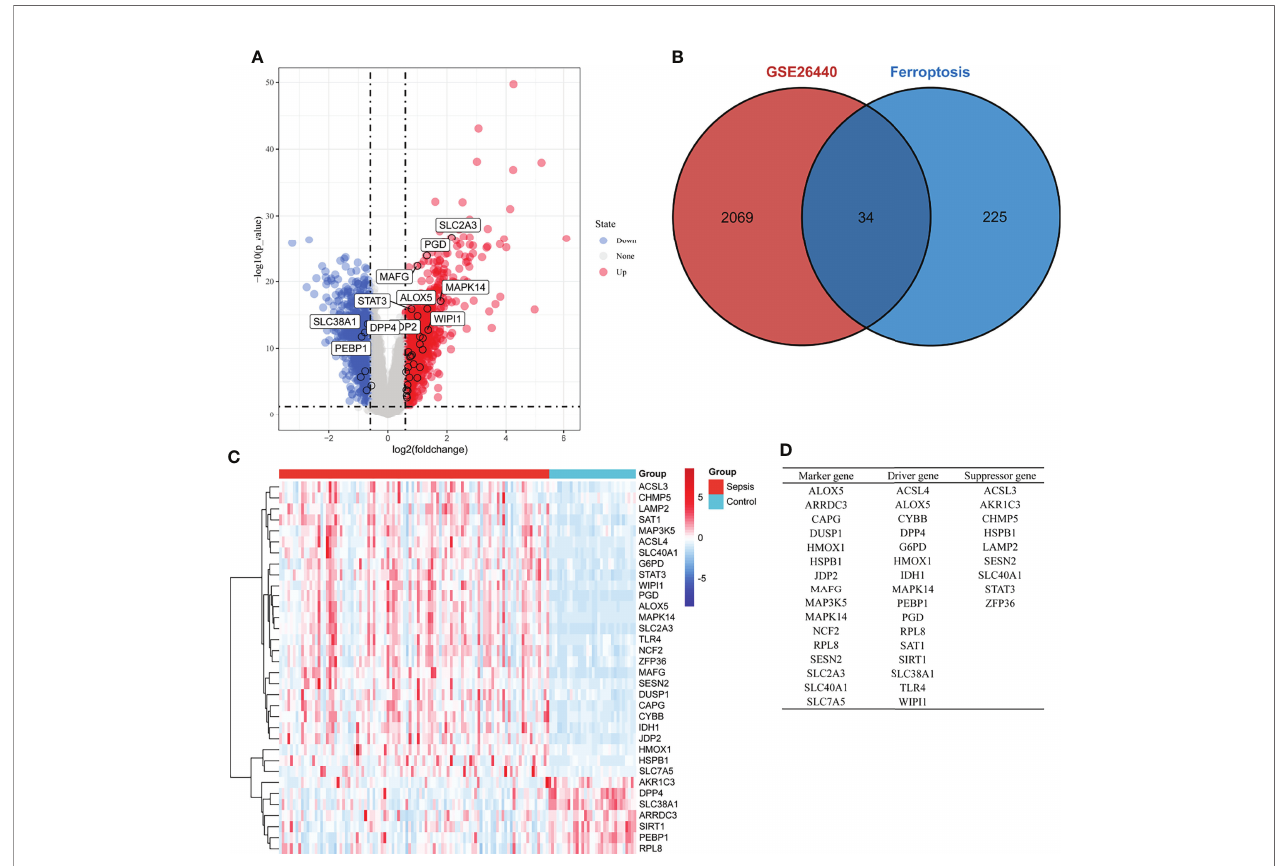
FIGURE 1 | Overview of the differentially expressed ferroptosis genes in children with sepsis and controls. (A) Volcano plot of genes differentially expressed between sepsis children and controls in the GSE26440 dataset. Blue nodes represent down-regulation in sepsis; red nodes represent up-regulation; and gray nodes represent no signi fi cant difference from controls. (B) Intersection of differentially expressed genes (DEGs) in the GSE26440 and ferroptosis genes. The count on the left (2,069 genes) refers to DEGs unique to GSE26440; the count in the middle (34 genes) refers to ferroptosis-related DEGs; and the count on the right (225 genes) refers to unique to ferroptosis genes. (C) Heat map of 34 ferroptosis-related DEGs. (D) Classi fi cation of 34 ferroptosis-related DEGs. Of these, 16 are marker genes, 16 are driver genes, and 9 are suppressor genes. ALOX5, MAPK14, and RPL8 may be both marker and driver genes; HSPB1, SESN2, and SLC40A1 may be both marker and suppressor genes; HMOX1 may be both marker, driver, and suppressor